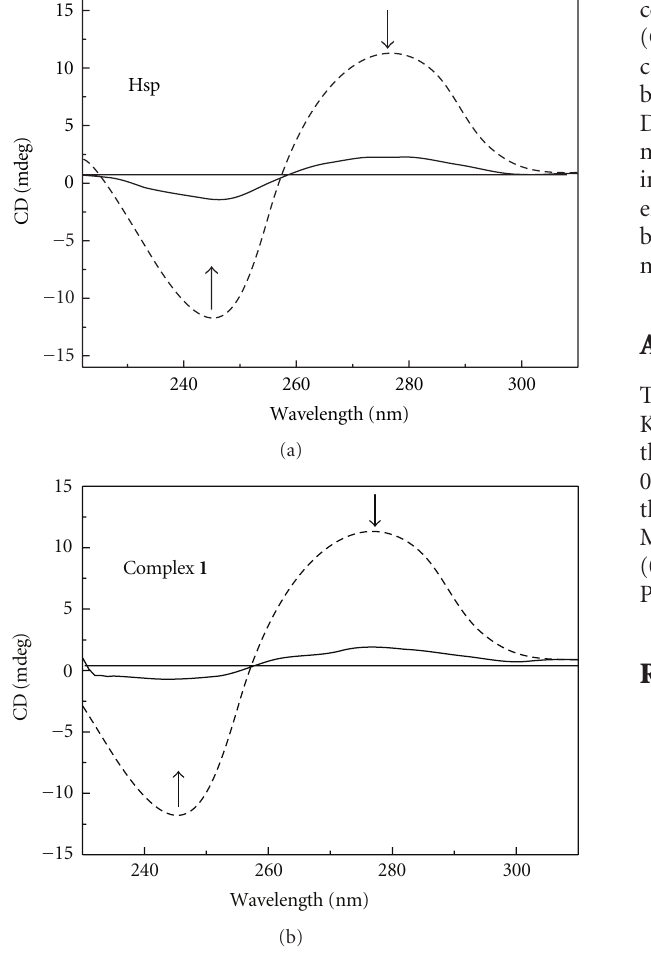
Figure 5: CD spectra of ct-DNA of Hsp and 1 in the absence (----) and presence (—) of